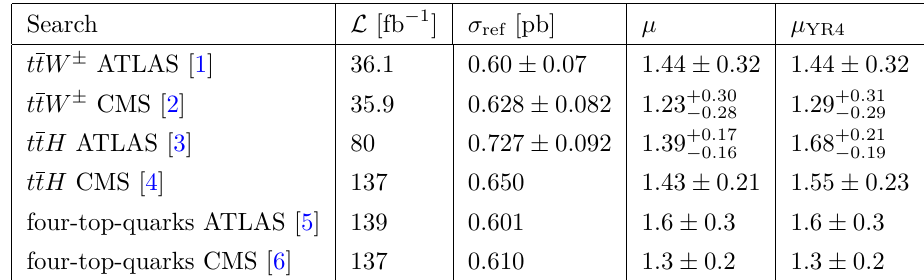
Table 1 . This table lists the ttW ± reference cross-sections and the corresponding signal strengths for different searches. The last column is the signal strength corresponding to the reference cross- section listed in ref. [7], 600 . 8 fb. The reference cross-section was not listed in ref. [6] and so it was taken from ref. [9].